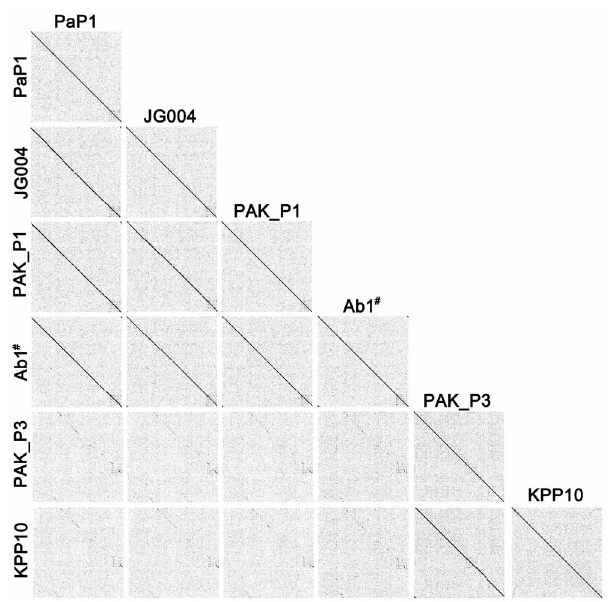
Figure 9. Dot plot of genome sequences of six phages using the program Gepard. The word length used is 9 bp; other parameters are set by default. The black dots indicate that the corresponding genome regions of the abscissa and the ordinate show similarity to each other. # The full name is vB_PaeM_C2-10_Ab1.